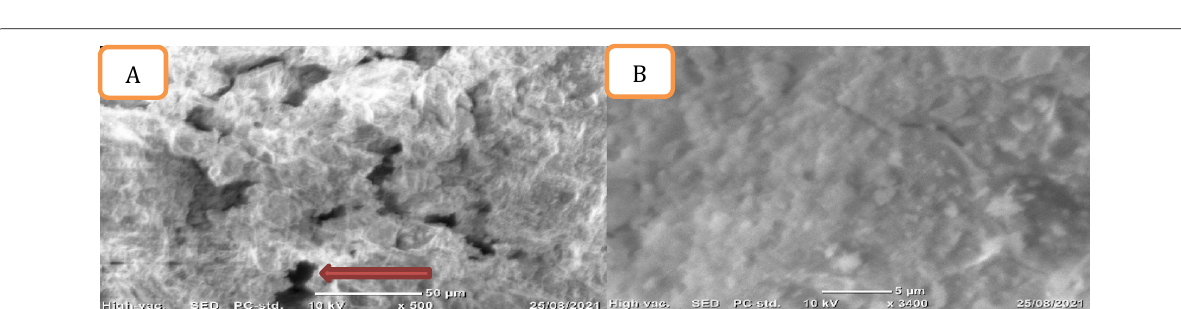
Fig. 11 SEM image of row MR2 mix (80% OPC and 20% EHC blended with GGBS) at different magnification rate a at magnification rate 50µm, and b at magnification rate 5